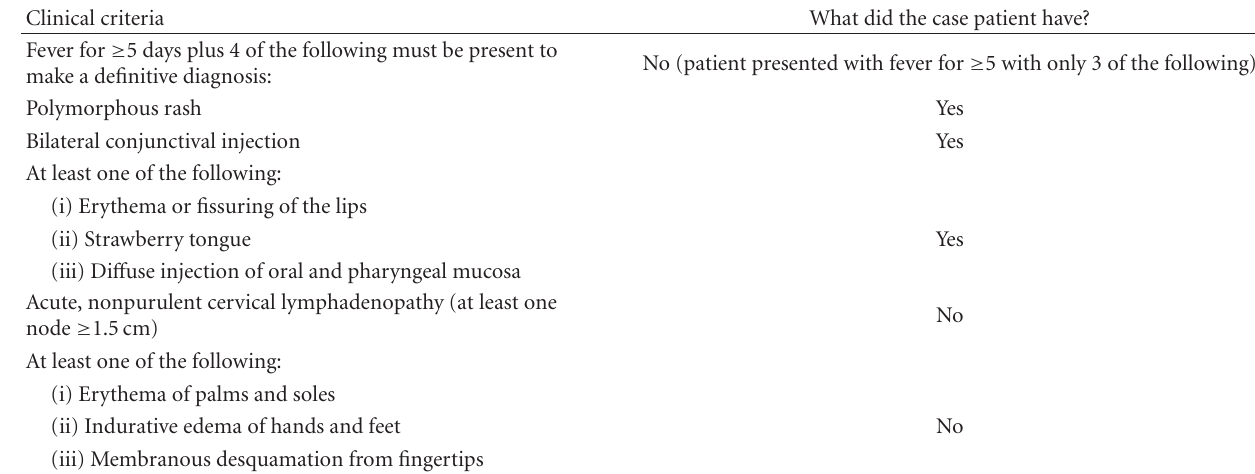
Table 3: Classic Kawasaki disease clinical diagnostic criteria.